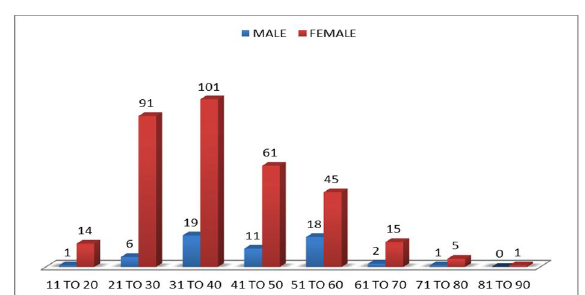
Figure 2: Female to male ratio according to age